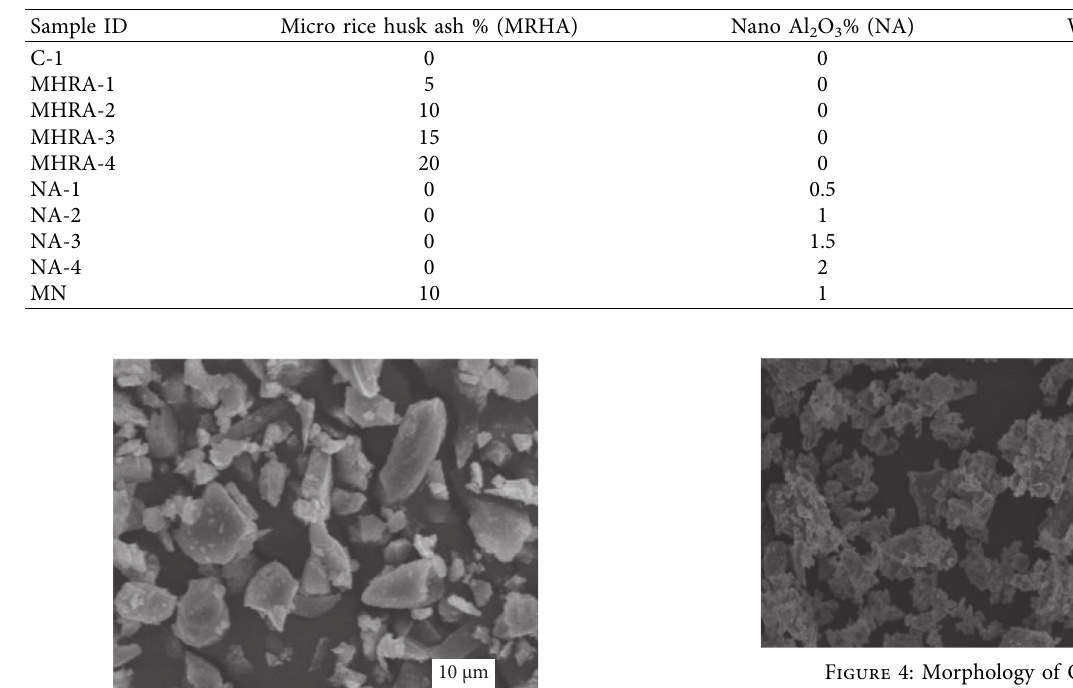
Table 1: Mix proportion.